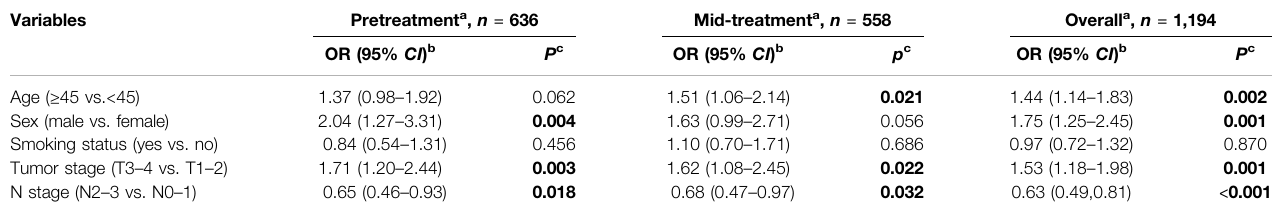
TABLE 2 | Multivariate associations of clinical characteristics with the oral Epstein – Barr virus DNA load at different treatment time points in nasopharyngeal carcinoma patients.